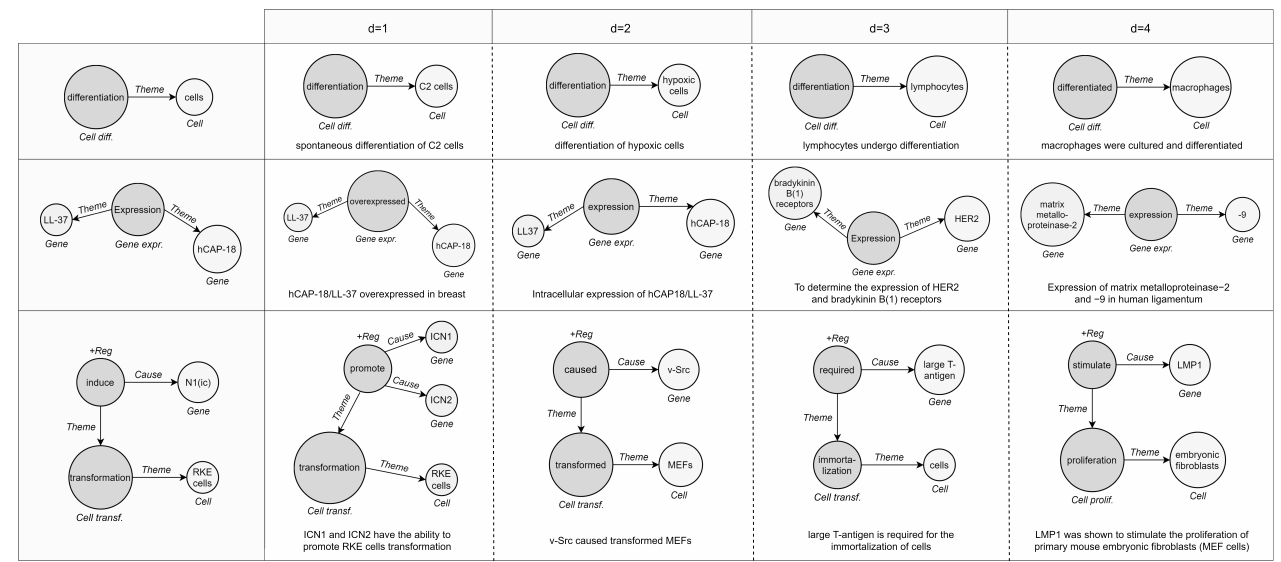
Figure 10. Query case studies on biomedical event graphs of different types and sizes. In each demo, the first column depicts the query and the others the similarity ranking of the retrieved graphs (and their mention). DDEGK correctly returns similar events in the structure or semantics of nodes/edges, also managing synonyms and acronyms thanks to SciBERT.